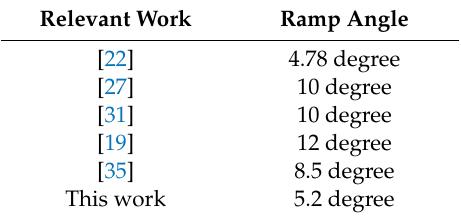
Table 2. Ramp angles selected in other relevant studies and comparison with our